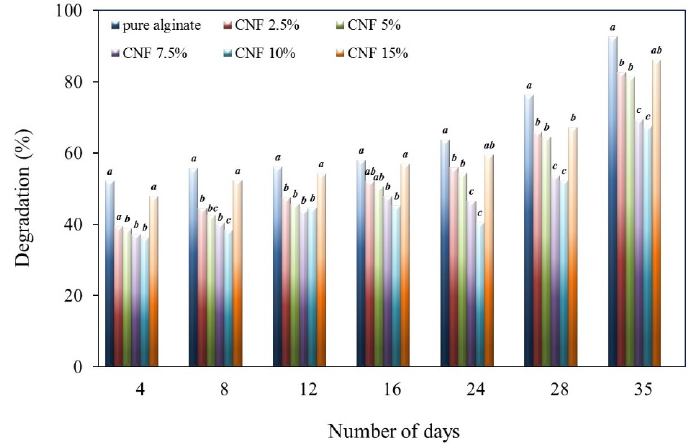
Figure 8. Effect of CNF content on the rate of degradation of alginate/CNF films (lower case letters (a, b, c) show Duncan grouping; distinct letters represent means significantly different ( p < 0.05)).